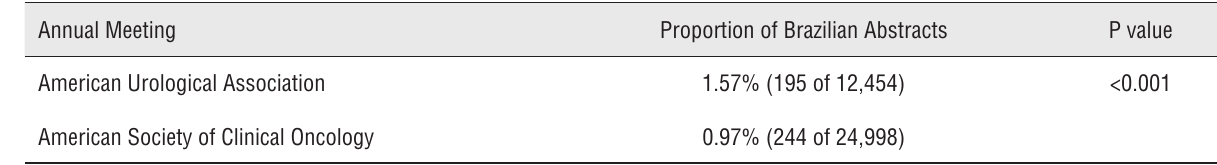
Table 1 - Comparison of contribution rates from Brazilian studies presented at the American Urological Association and American Society of Clinical Oncology Annual Meetings 2001 through 2007 (data for oncology are from Pinheiro et al. 22